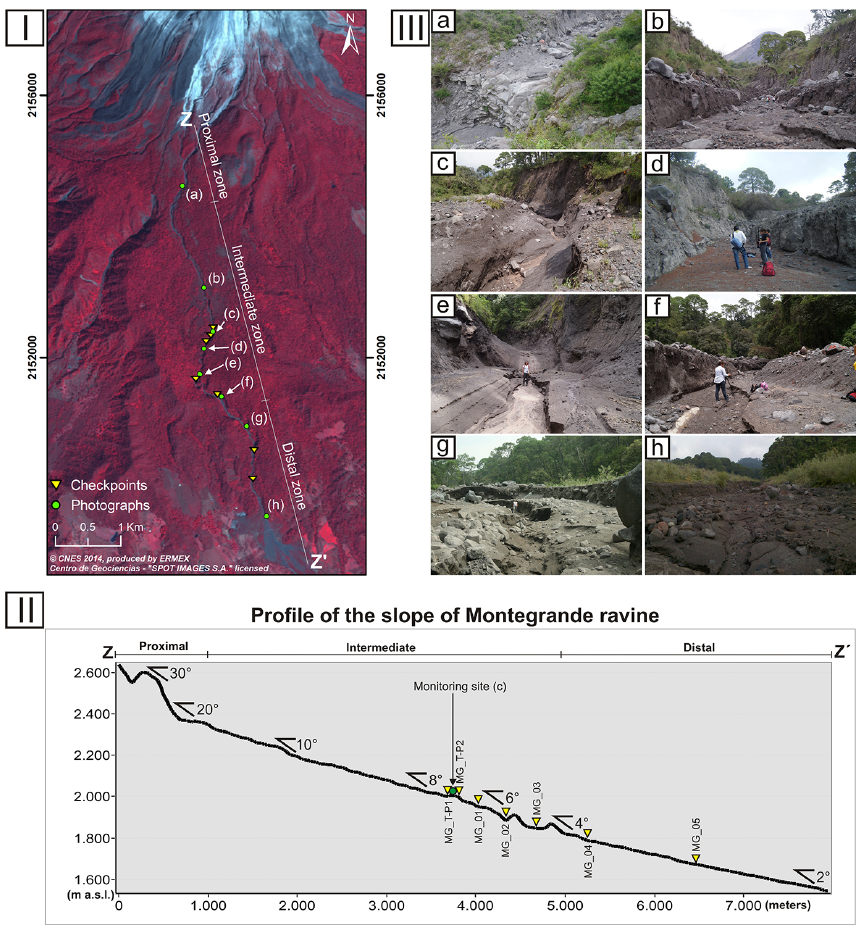
Figure 1. [I] SPOT 5 image (1, 2, 3, and 4 bands in RGB combination, 5m of resolution) of Volcán de Colima showing the Montegrande ravine and the location of the checkpoints. Yellow triangles represent the location of the analyzed cross sections, green dots the location where the photos were taken: within the proximal zone (a, b) , the intermediate zone (c, d, e, and f) and the distal zone (g, h) . [II] Topographic profile along the ravine, showing its slope values and the location of the checkpoints and the monitoring